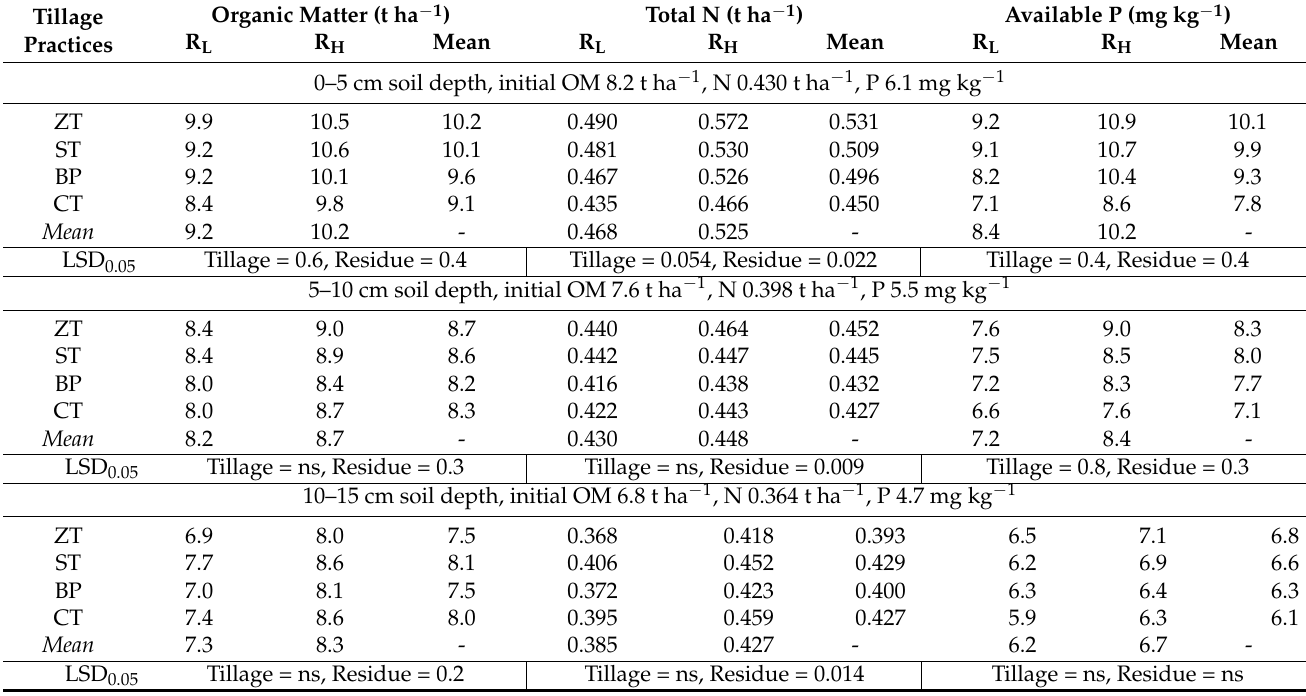
Table 4. Effect of tillage practices and residues retention on soil organic matter stock, total nitrogen stock and available phosphorus concentrations in soils after 3